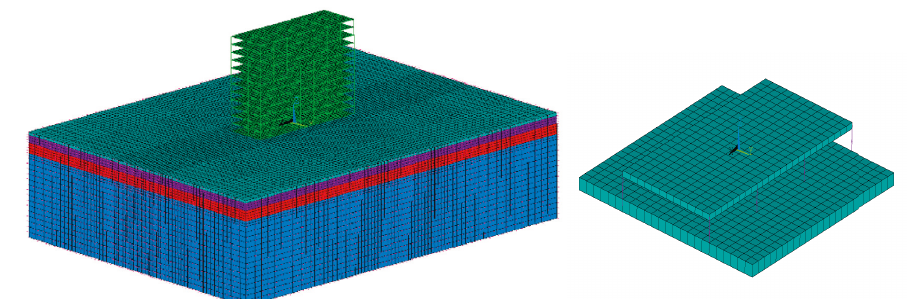
Figure 9: Soil-building-isolation slab finite element